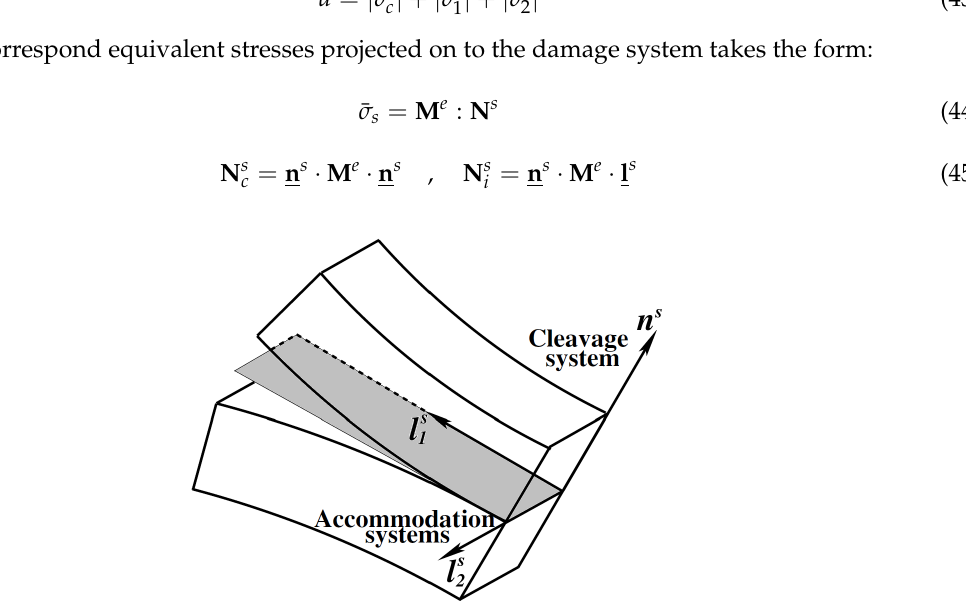
Figure 2. Schematic representation of the damage systems associated to the crystallographic